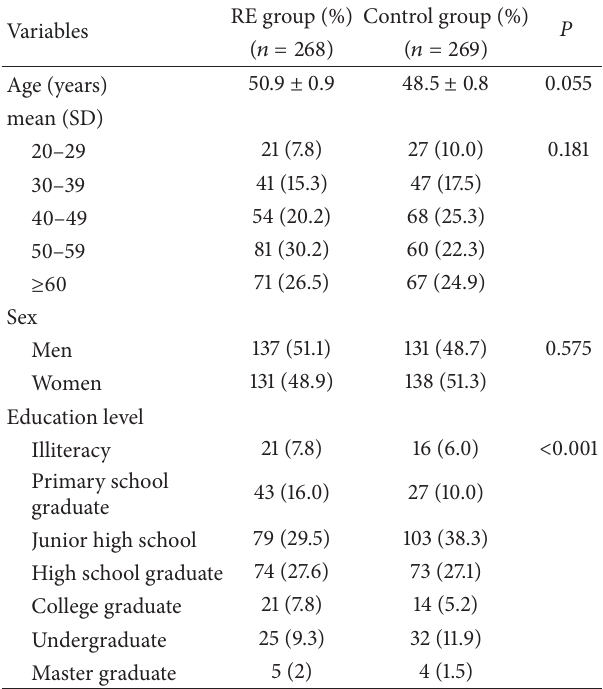
Table 1: Comparison of the RE group and control group.